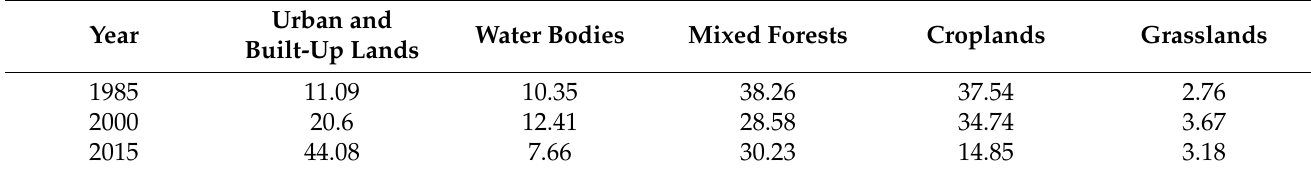
Table A1. The state vectors of land use/land cover classification for Z01 in 1985, 2000, and 2015 (%).